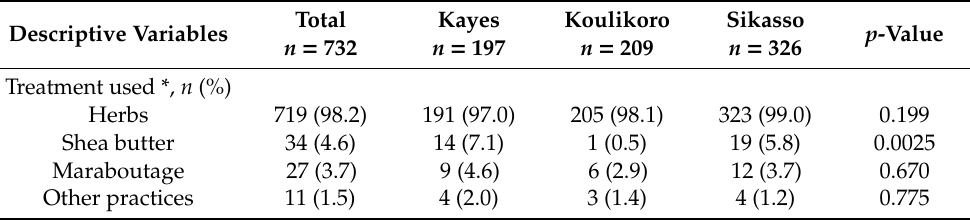
Table 3. Treatments most cited by the traditional healer (for all pathologies) *.